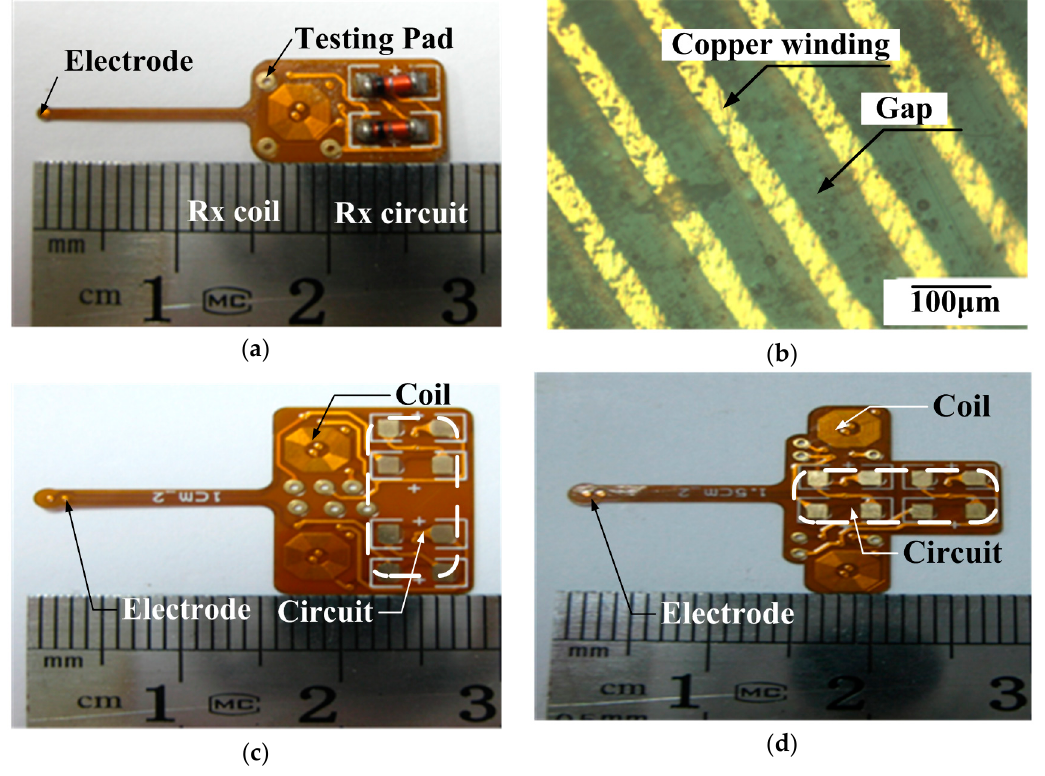
Figure 5. ( a ) Photograph of the single channel stimulator board; ( b ) Microscope image of the four-layer FPC coil (local). The four-layer FPC coils have a line width and spacing of 50 µm and a thickness of 17.5 µm; ( c ) A two-channel IPG interface with 10mm coils center distance; ( d ) A two-channel IPG interface with 15 mm coils center distance.